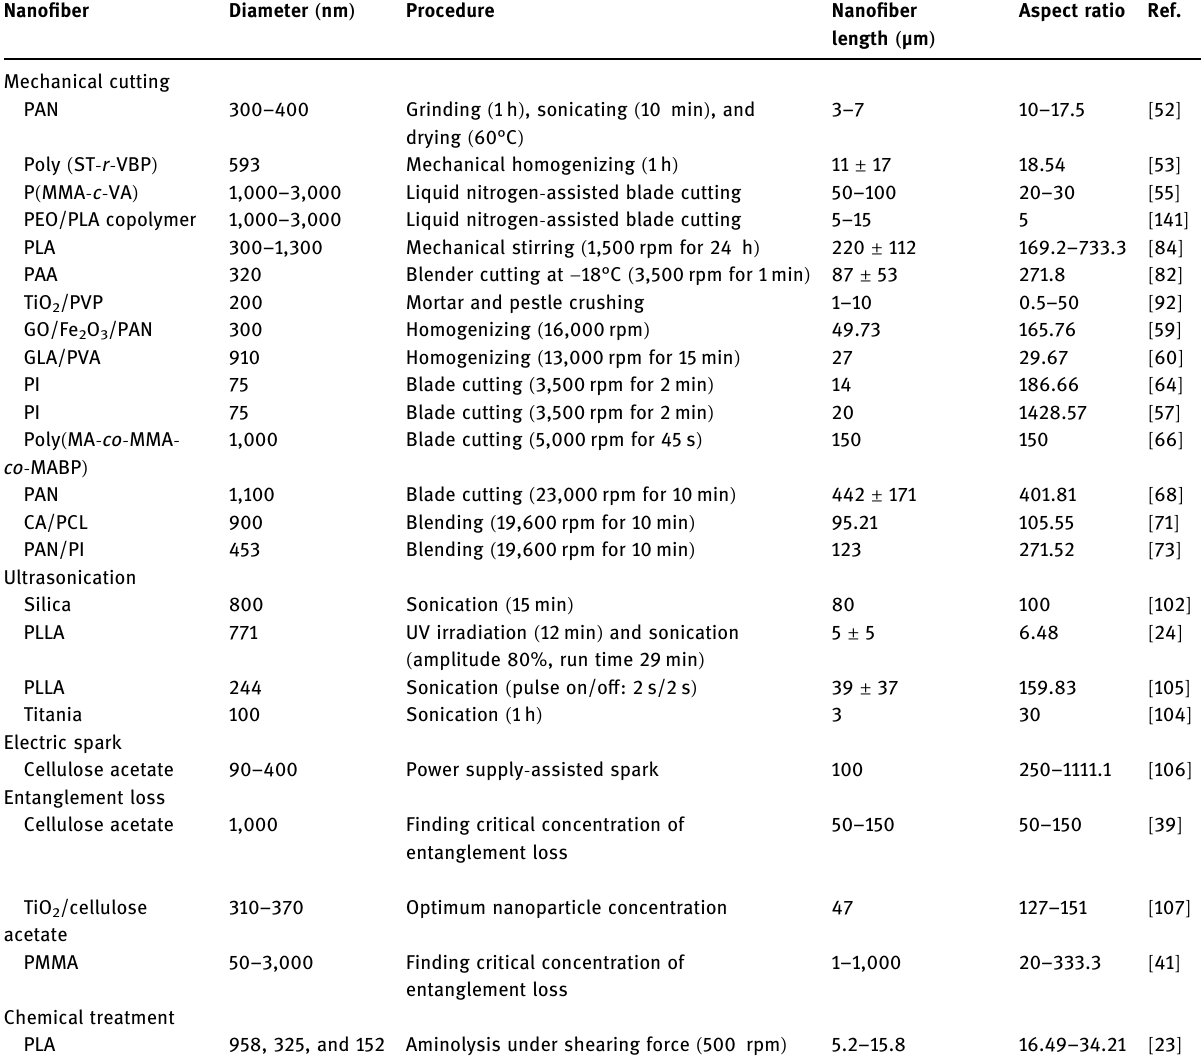
Table 4: Summary of short nano fi ber preparation parameters and results Nano fi